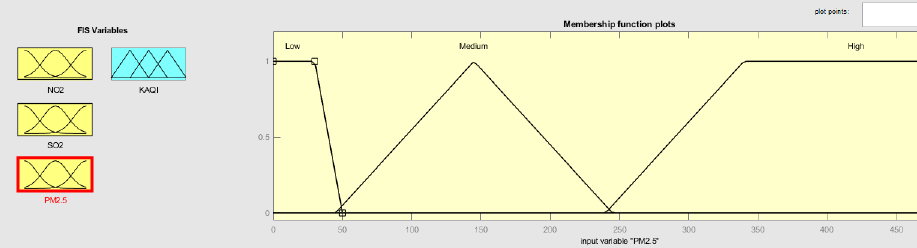
Figure 6. PM 2.5 input variable.